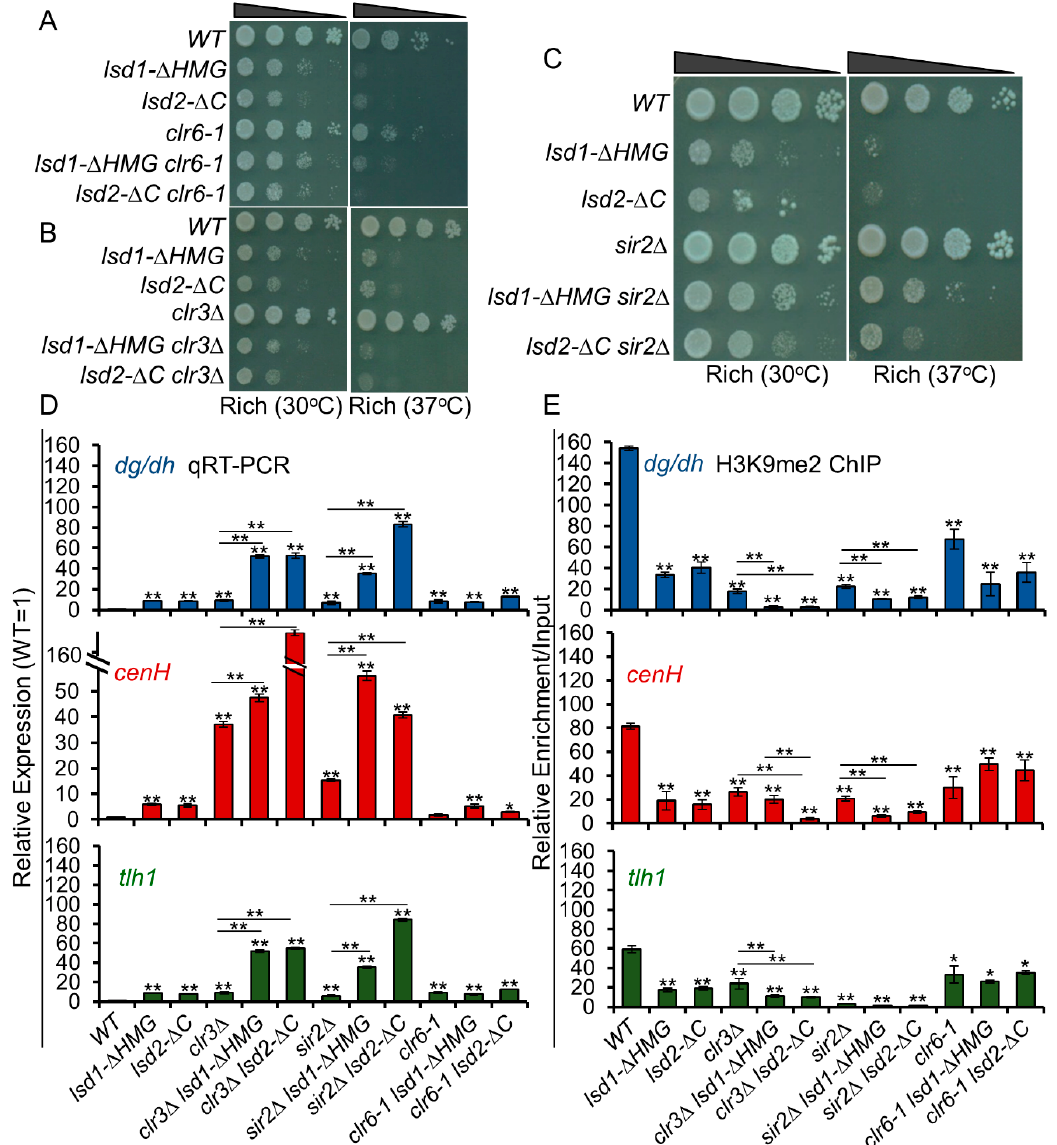
Figure 7 . Lsd1 and Lsd2 mediate overlapping functions with Clr3 and Sir2, but not with Clr6, at heterochromatic regions. ( A – C ) Serial dilutions show genetic interactions with respect to growth and heat sensitivity between lsd C-terminal mutants and mutants of histone deacetylases clr6-1 ( A ), clr3 Δ ( B ), and sir2 Δ ( C ). ( D ) qRT-PCR analysis shows cumulative silencing defects of Lsd mutants combined with HDAC mutants at the centromeric ( dg/dh ), mating-type locus ( cenH ), and telomeric ( tlh1 ) heterochromatin regions. (E) H3K9me2 ChIP analysis demonstrates the alterations of heterochromatin in WT, single, and double mutant cells with the indicated genotypes . * p ≤ 0.05 and ** p ≤ 0.01 as determined by student’s t test comparing the indicated samples with WT for qPCR or qChIP and by horizontal lines linking the two samples. Error bars represent